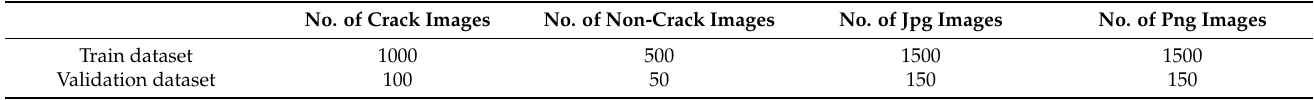
Table 2. Training and validation datasets for semantic